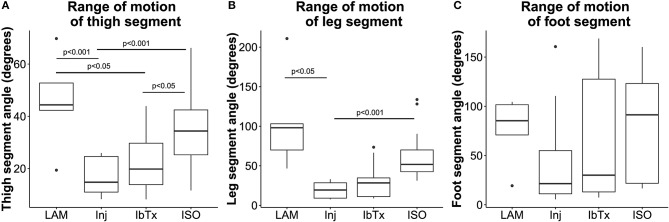
Improved neuro-protection translates to improved ROM in spinal cord injured rats treated with ISO. Eight weeks post-injury, 2D gait analysis was performed as described in Materials and Methods. Maximum thigh (A), leg (B), and foot (C) segment angles were assessed. Laminectomised rats and SCI rats treated with ISO had significantly greater ROM of thigh and leg segment angles compared to injured non-treated animals. There were no significant differences in foot segment angle ROM. Tukey box plots are shown. LAM n = 3; Inj = 6; IbTx = 6; ISO = 13.